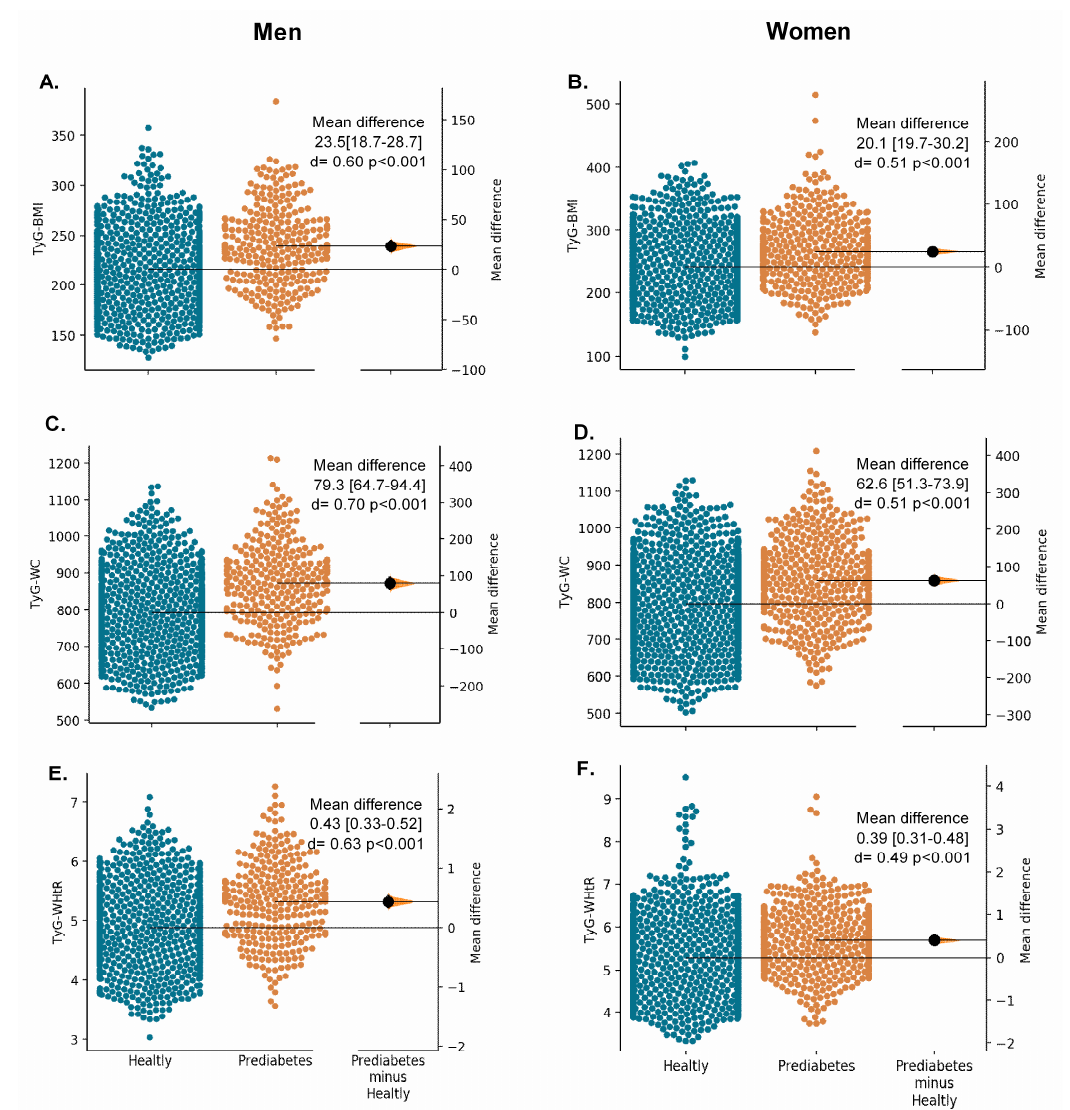
Figure 4. The Gardner–Altman plots for unadjusted surrogate obesity indices (TyG-BMI, TyG-WC, and TyG-WHtR) according to glycaemia status and sex.